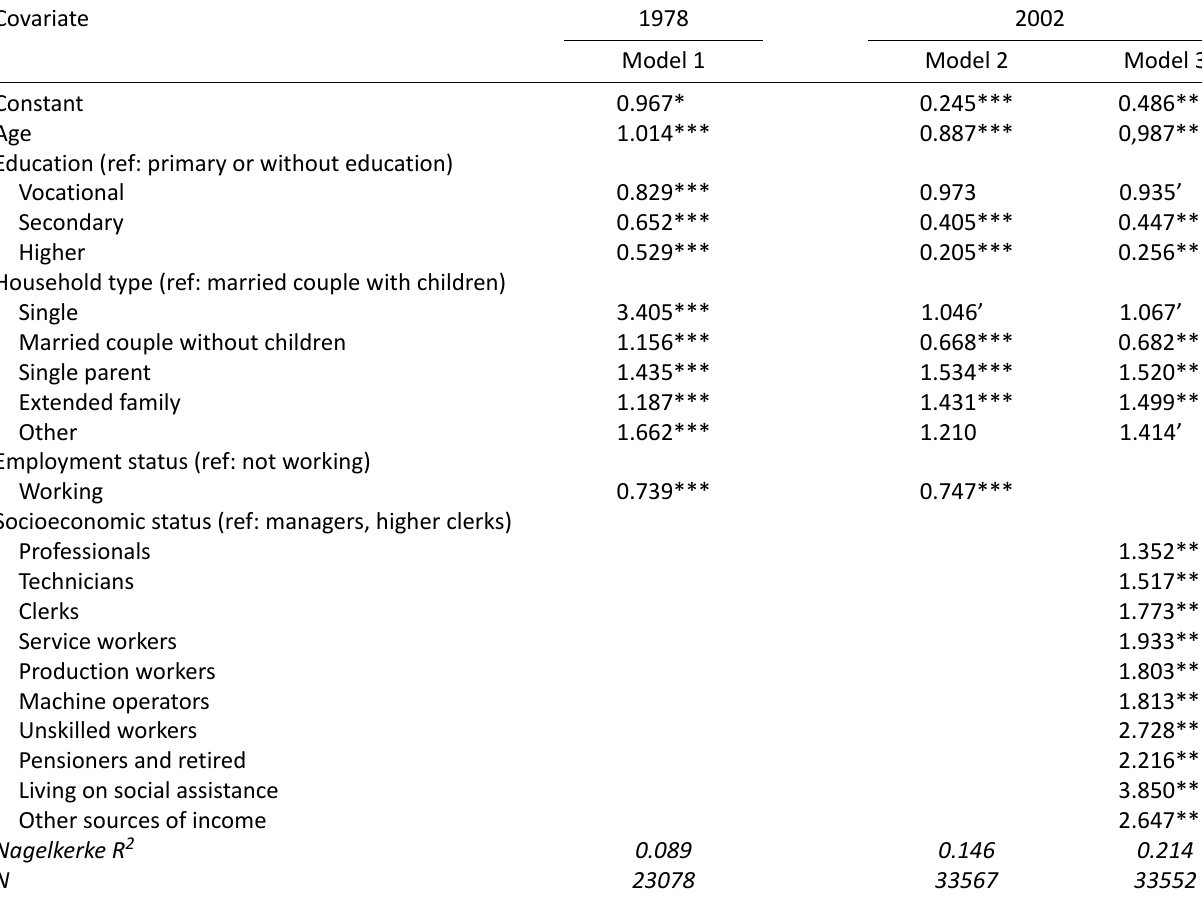
Table 2. Binominal logistic regression models on reliance on public housing, Lodz, 1978 and 2002.